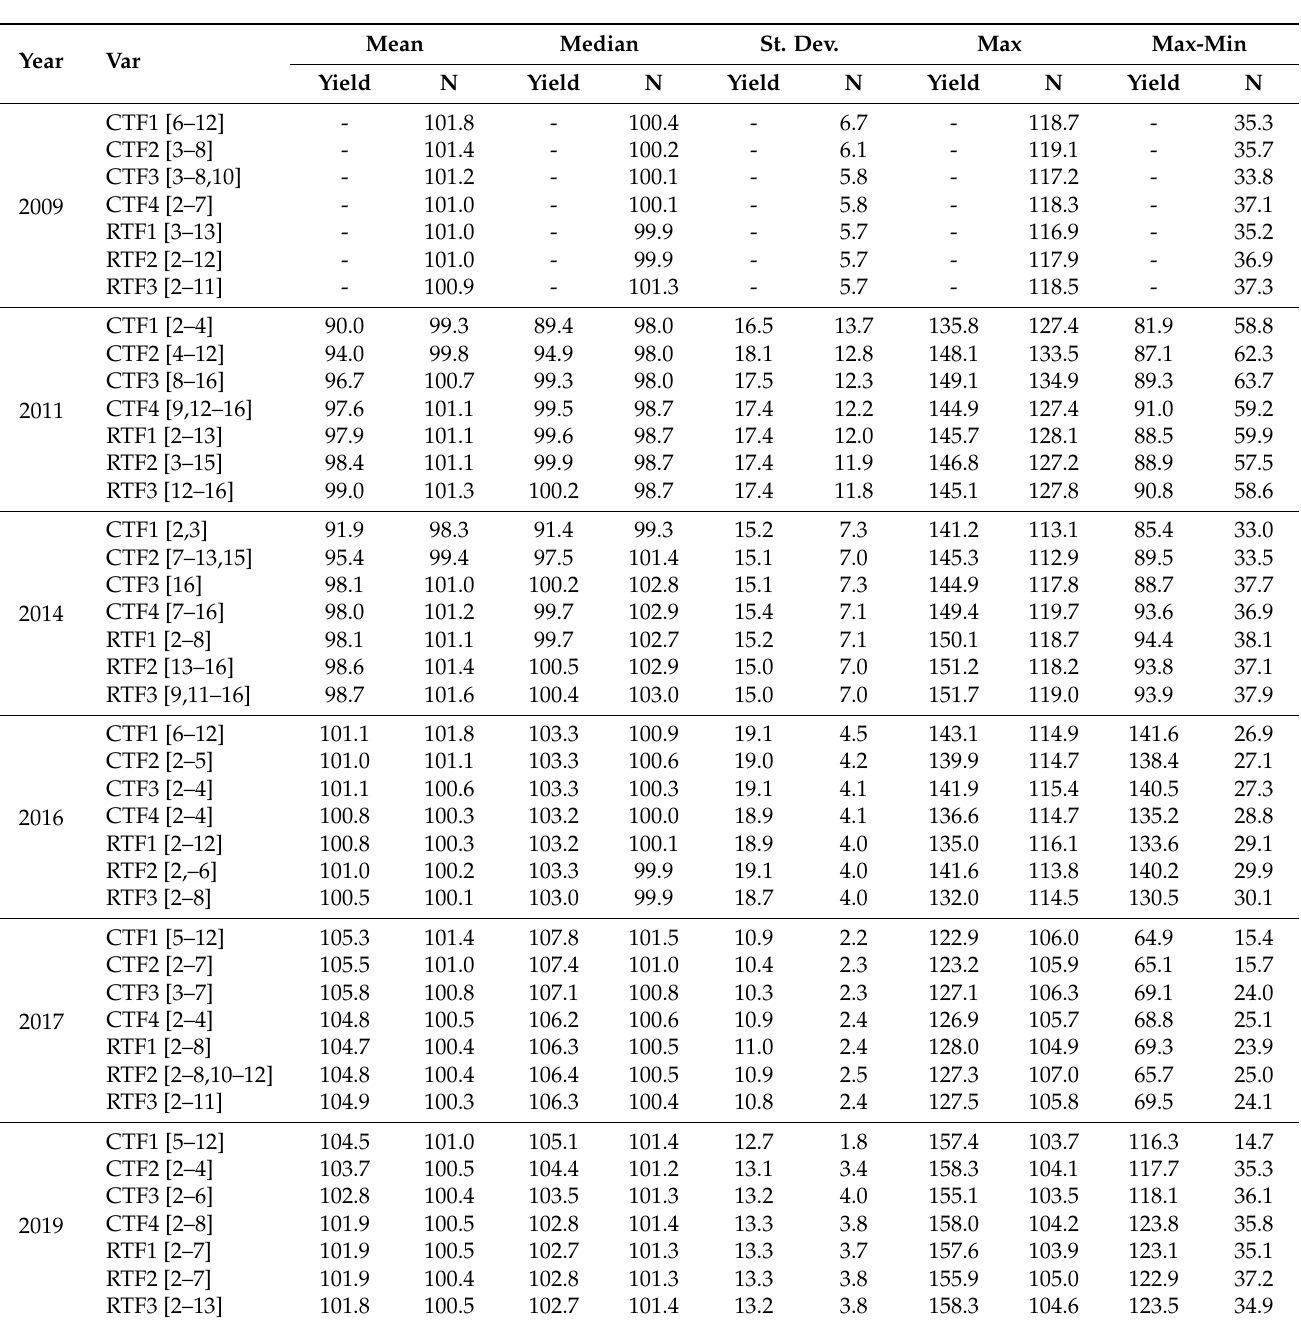
Table 3. Summary statistics of resulting relative yield in % and relative NDVI (N) in % for selected years (Y) and individual types of traffic management (Var). Tukey HSD test of homogenous groups [1, 2, . . . ], α =